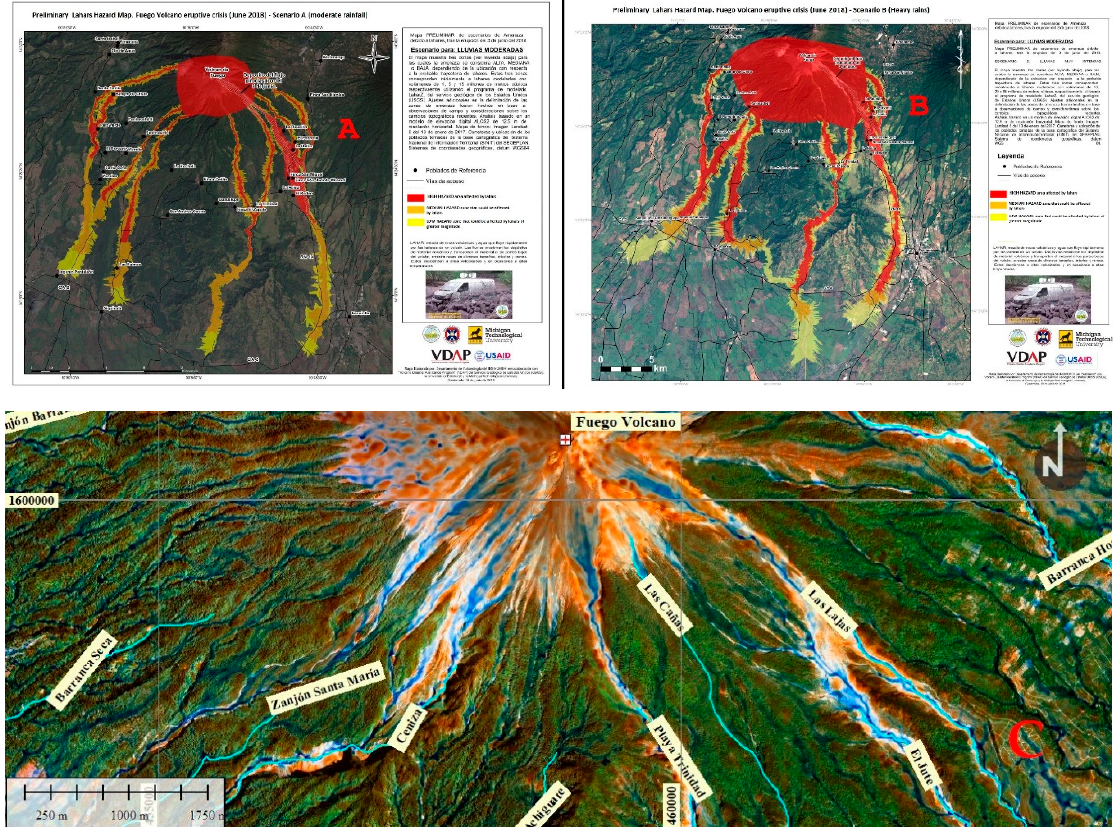
Figure 1. Web Map prepared by MapAction as a collaborator on the HazMap project and in support of National Institute of Seismology, Volcanology, Meteorology and Hydrology (INSIVUMEH). Data from preliminary maps of the hazard of pyroclastic flows and lahars for scenario A (moderate rainfall)